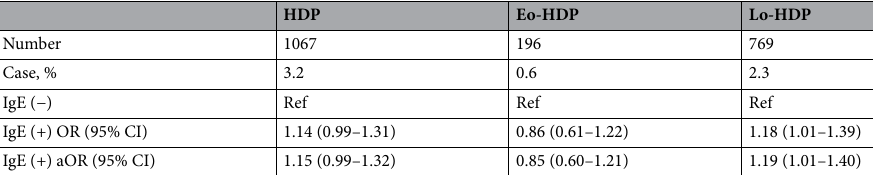
Table 3. Relationship between IgE levels ≥ 170 IU/ml and HDP, Eo-HDP, and Lo-HDP. aOR was calculated by logistic regression analysis, using maternal age, body mass index before pregnancy, systemic lupus erythematosus, maternal smoking status, and maternal education. IgE immunoglobulin E, HDP hypertensive disorders of pregnancy, Eo early-onset, Lo late-onset, OR odds ratio, CI confidence interval, aOR adjusted odds ratio, Ref